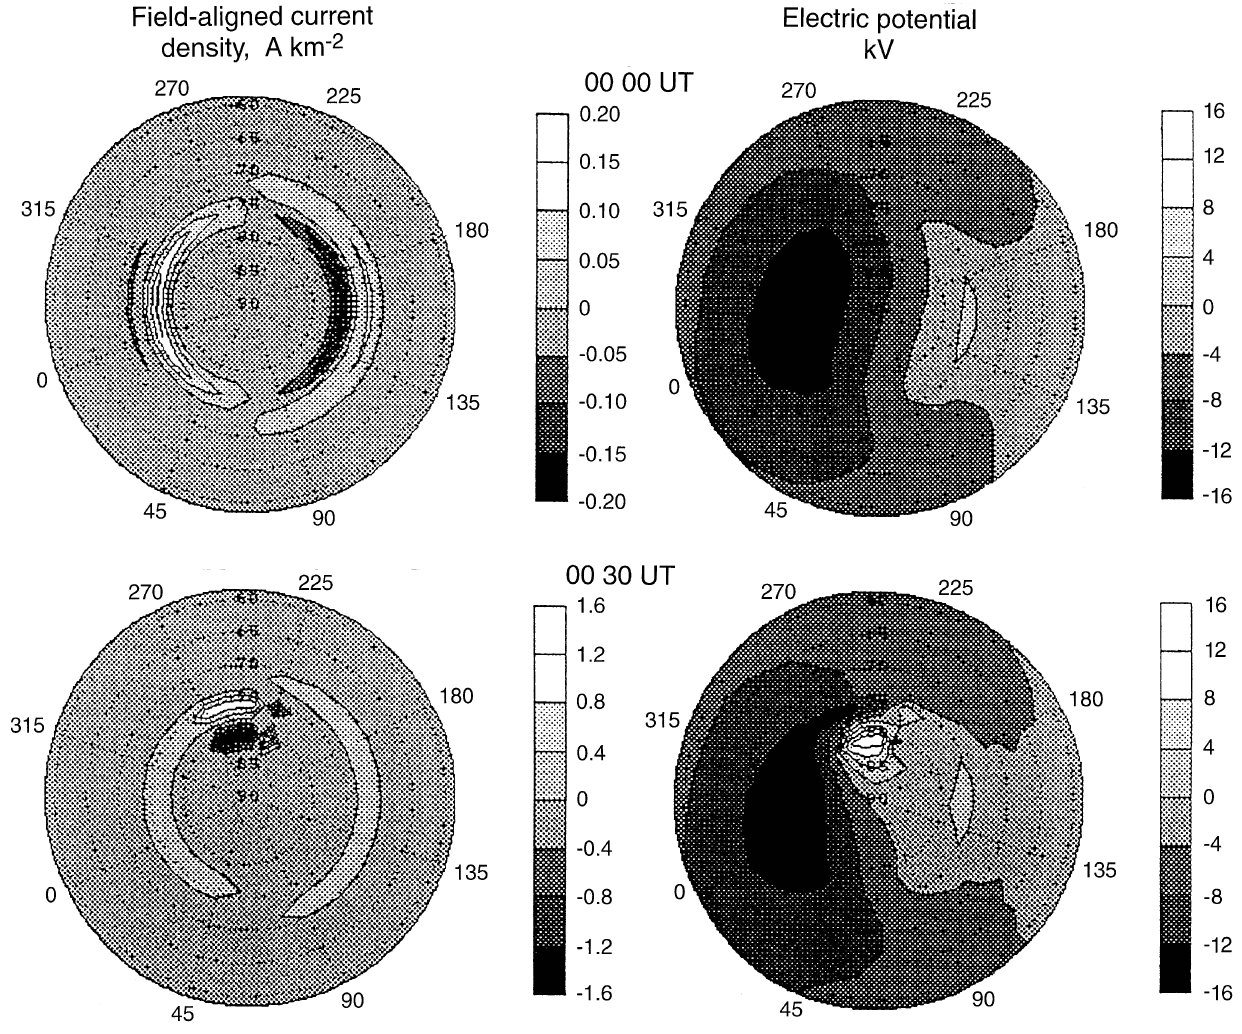
electric-field potential ( right - hand plots ) at 0000 UT (top) and 0030 UT (bottom)